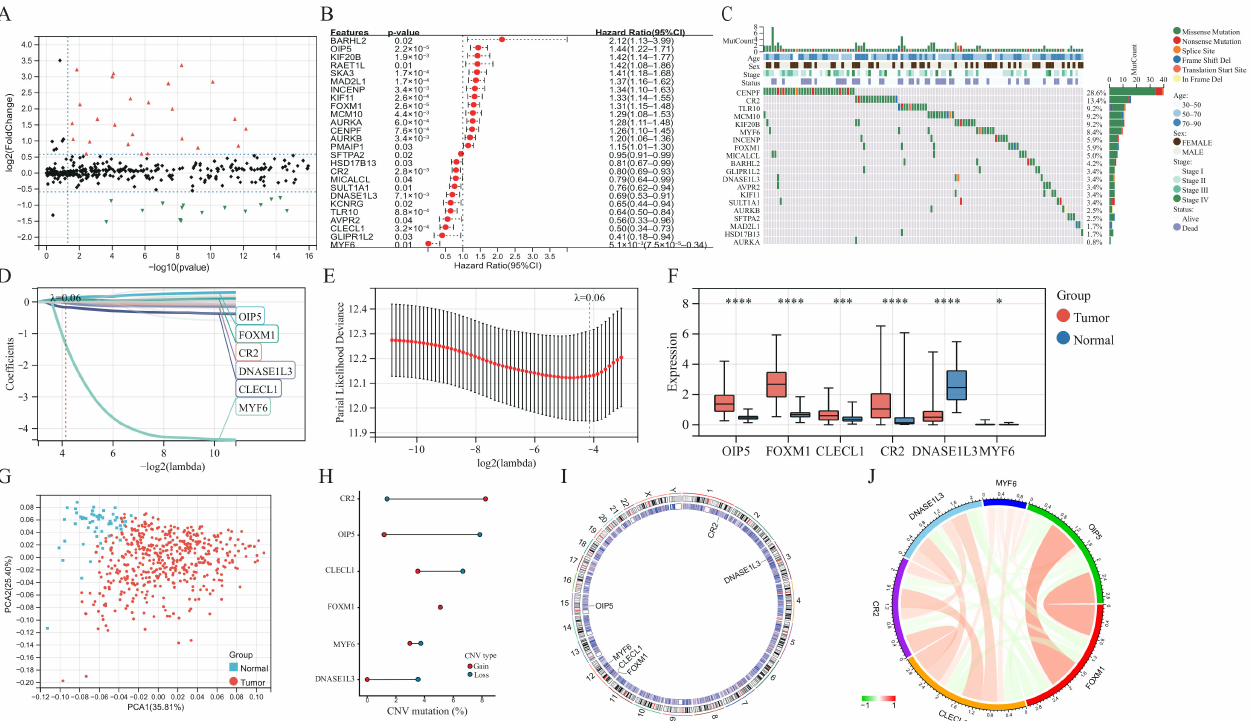
Figure 1. Determination and characterization of GSTTK involved in lung adenocarcinoma (LUAD). ( A ) Volcano map displays the 99 GSTTK with differential mRNA levels between cancerous and para-cancerous tissues in the TCGA-LUAD cohort. Red indicates up-regulation and green indicates down-regulation. ( B ) Univariate Cox analysis of 26 GSTTK related to overall survival (OS) in LUAD. ( C ) Waterfall plot shows the mutational scenery of 26 GSTTK and the clinicopathological features. ( D , E ) Lasso analysis identified six genes that were closely related to OS in the TCGA-LUAD cohort. ( F ) The six GSTTK are expressed differentially in cancerous and para-cancerous tissues. Tumor and normal samples are indicated in red and blue, respectively. The upper and lower ends of boxes indicate the interquartile range. Line in the boxes indicates median values. Asterisks indicate significance, * p < 0.05; *** p < 0.001; **** p < 0.0001; -,no statistical significance. ( G ) Principal component analysis differentiated cancerous (red) and para-cancerous (blue) tissues. ( H ) Copy number variation (CNV) in the six GSTTK in LUAD. Gain, red dots; Loss, blue dots. ( I ) CNV locations of the six GSTTK are tagged on the chromosome. ( J ) Correlation between the expression of the six GSTTK in the TCGA-LUAD